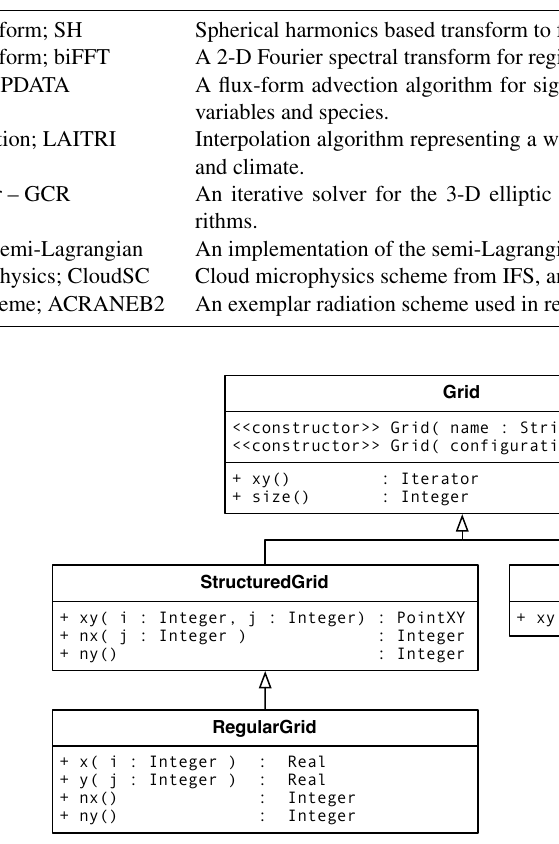
Figure 4. Object orientation and the Grid classes supported in Atlas. Specific model grids can be constructed as instances of one of these classes. For example, the current ECMWF high-resolution (9km) octahedral reduced Gaussian grid is an instance of the StructuredGrid , but can be referred to by the name Ø1280, which it inherits from the Grid